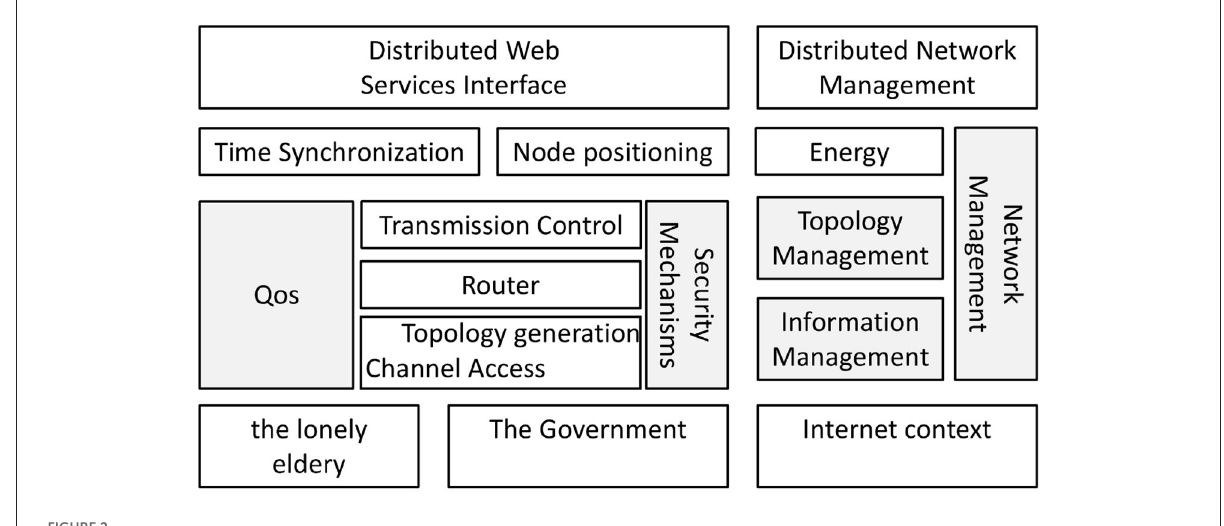
FIGURE2 Action strategy framework.